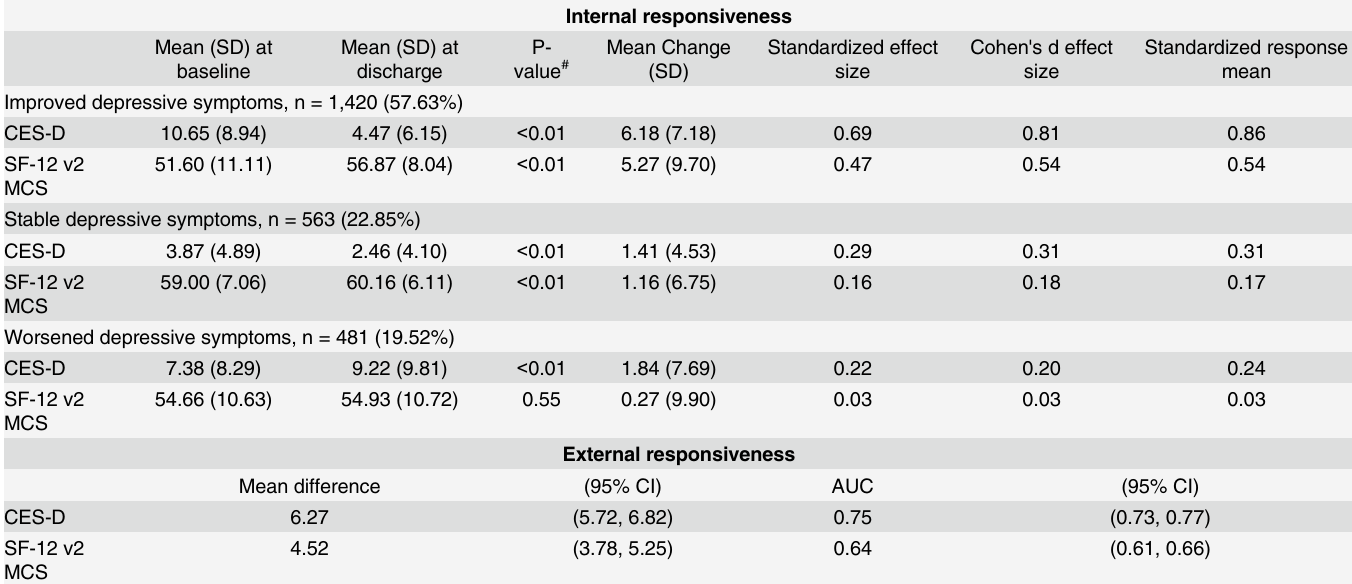
Table 5. The responsiveness of the CES-D and the SF-12 v2